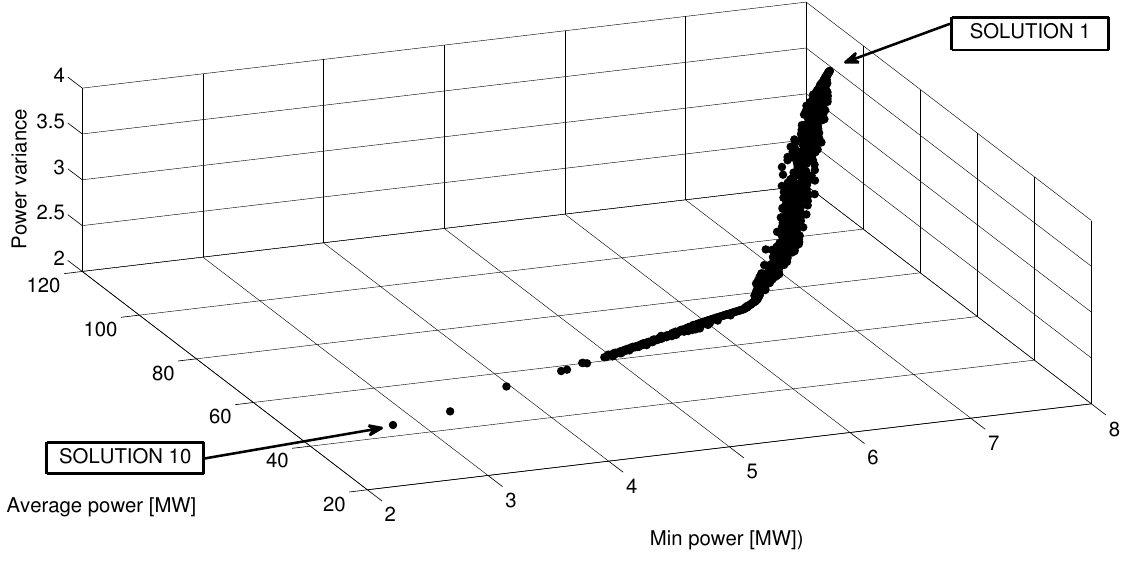
Figure 6. Simulation results: 3D Pareto front.